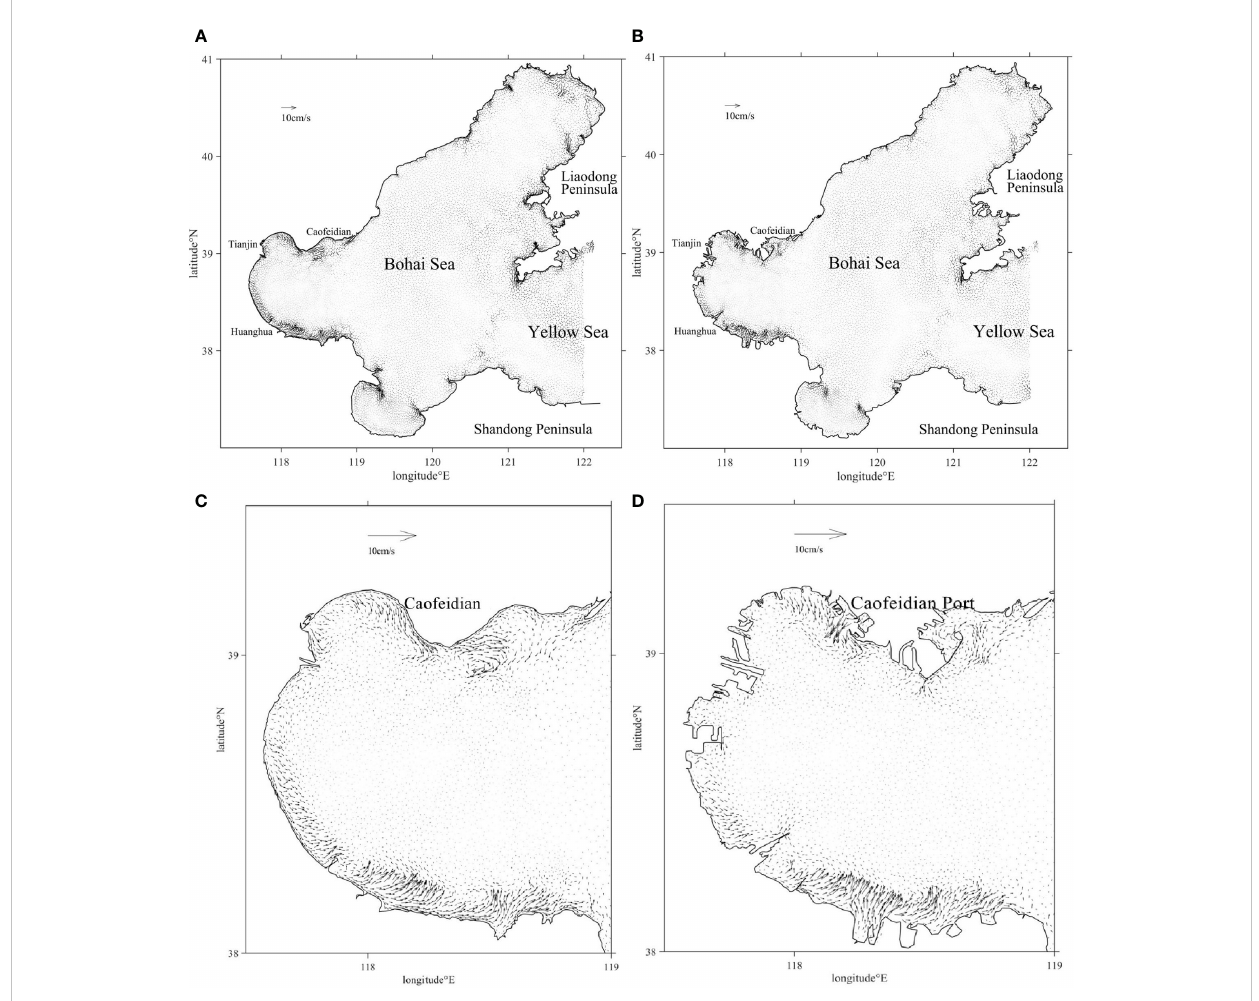
FIGURE 8 Simulated Eulerian tidal residual currents in (A) BHS in 1999; (B) BHS in 2019; (C) Bohai Bay in 1999; (D) Bohai Bay in